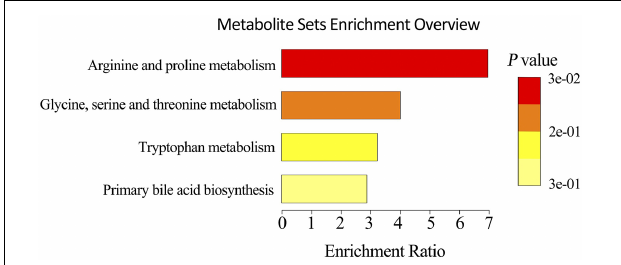
FIGURE 4 | Metabolic pathway enrichment analysis. Overview of metabolites that were changed in the feces of M2 pigs compared to FA pigs. FA, pigs had free access to feed; M2, pigs were given two meals per day (0800 and 1800 h); each meal lasted 60